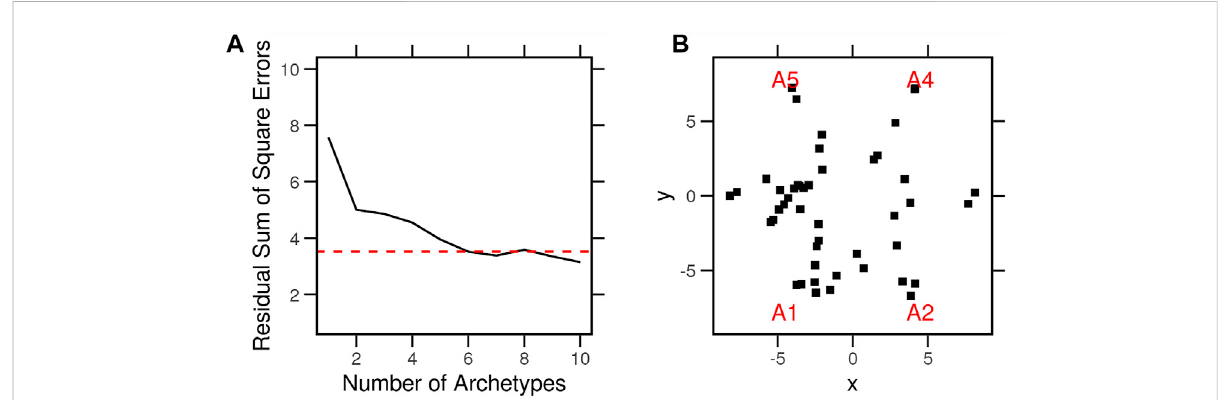
FIGURE 3 Archetypes of the typical gene expression pro fi les of cancer cell lines. Typical expression pro fi les were determined by averaging the control condition of each cell line ( N = 46) in the LINCS dataset. A set of archetypes was determined from the typical expression pro fi les so that the data are approximated byaconvexcombinationoftheextremalpoints.Theproblemisde fi nedandsolvedascontextleastsquaresusinglinearequations. (A) Procedure was repeated with several archetype numbers, and the residual sums of square errors were calculated. (B) Archetypes (red) and cell lines (black) in parallel coordinates of a model with six